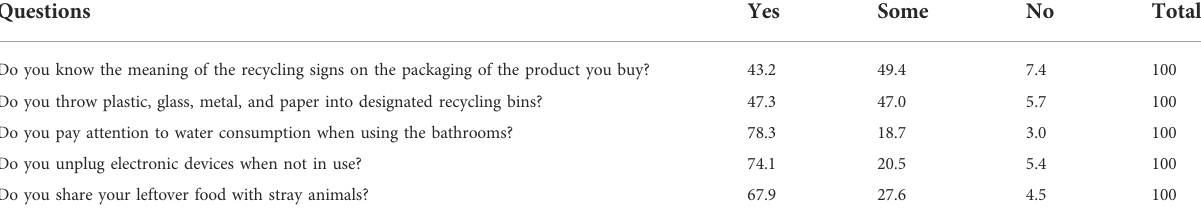
TABLE 2 Percentage table of some of the waste management responses.